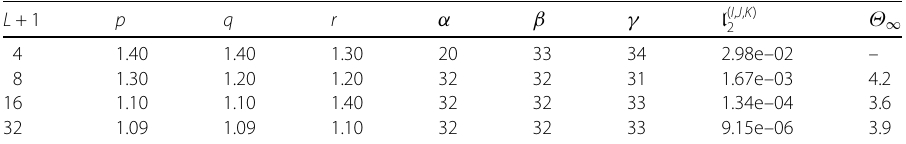
Table 2b Errors and computational rate for the EF-EEG-TOCS in Example 5.2